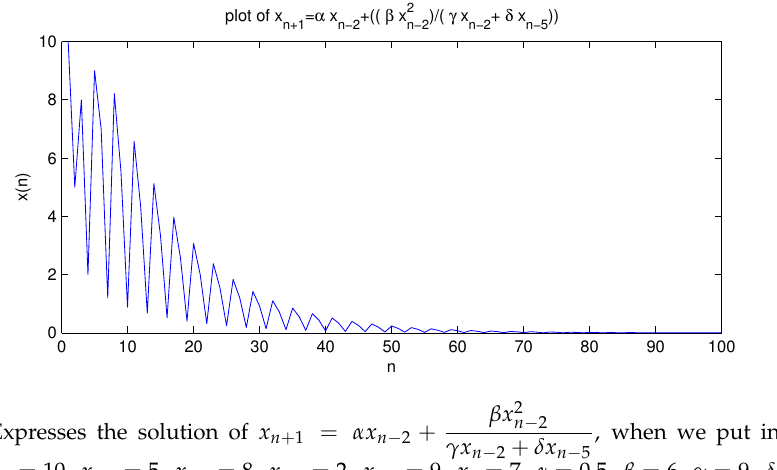
β x 2 n − 2 , when we put initials and γ x n − 2 + δ x n − 5